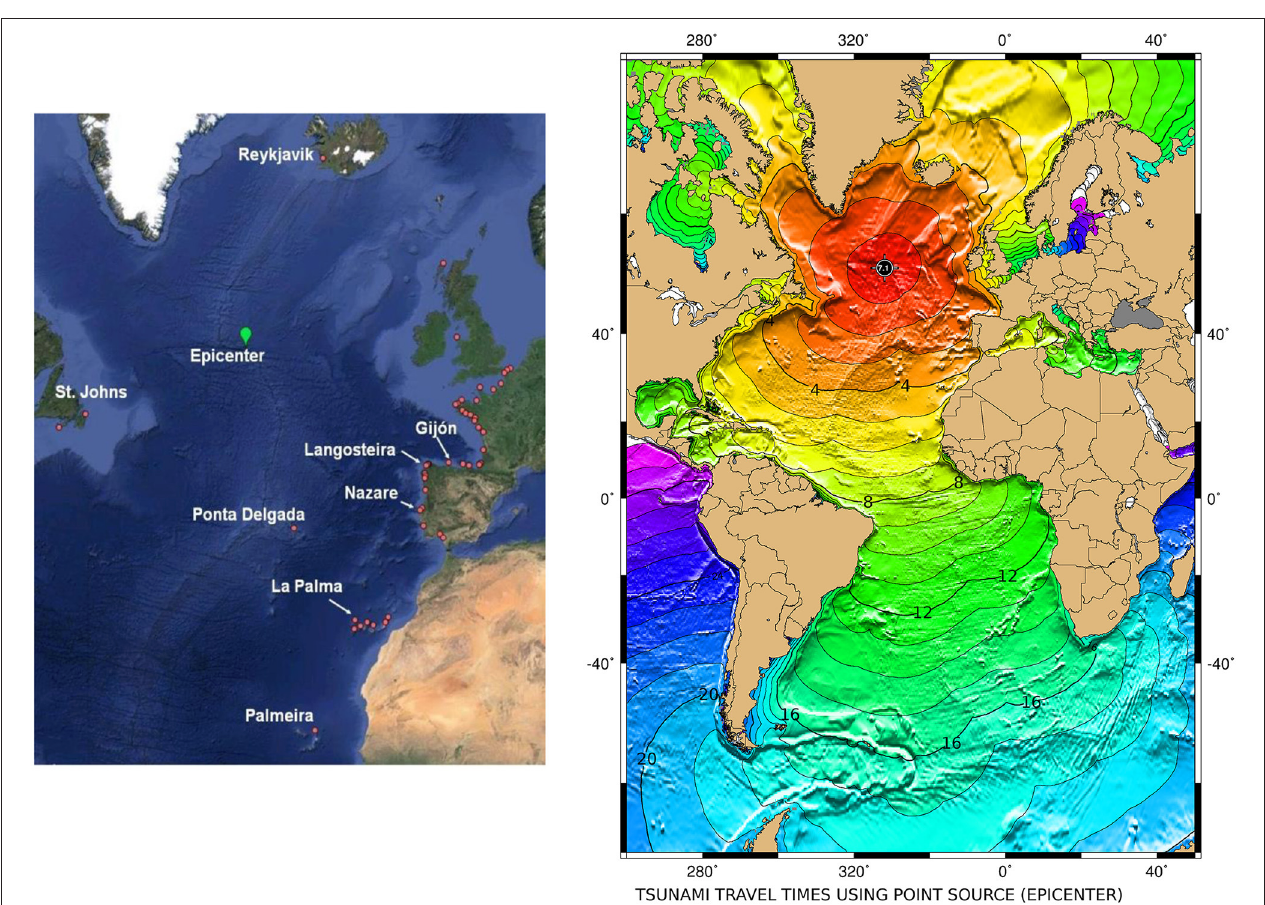
FIGURE 10 | Left: up to 50 tide gauges (red dots) with 1-min data were available during the 13th of February 2015 earthquake event. Only a subset of them presented a possible small signal; the most evident was observed in Langosteira tide gauge; right: tsunami propagation (1h contour line) generated at the epicenter of the earthquake of 13th February 2015, 18:59:12 UTC, in the Atlantic ridge, as provided by the model TTT SDK v3.3.